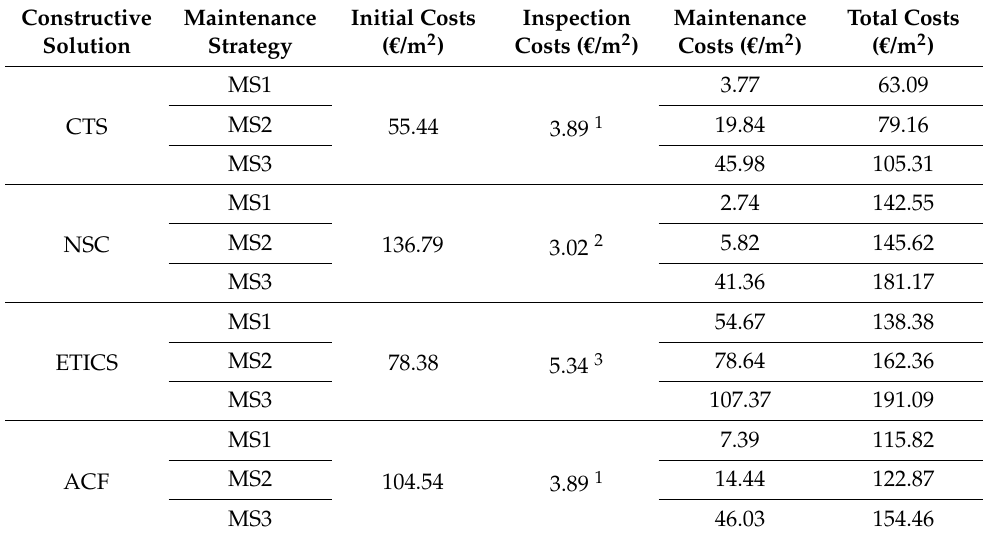
Table 3. Comparison of the costs (initial, inspection, maintenance and total) of the four constructive solutions for the three maintenance strategies.